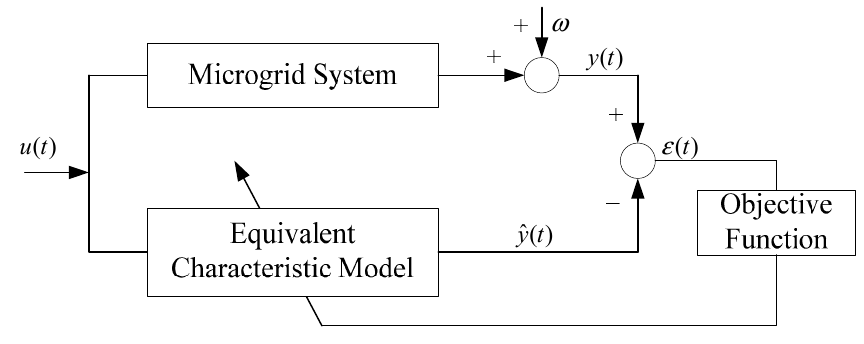
Figure 5. Characteristic modeling process.